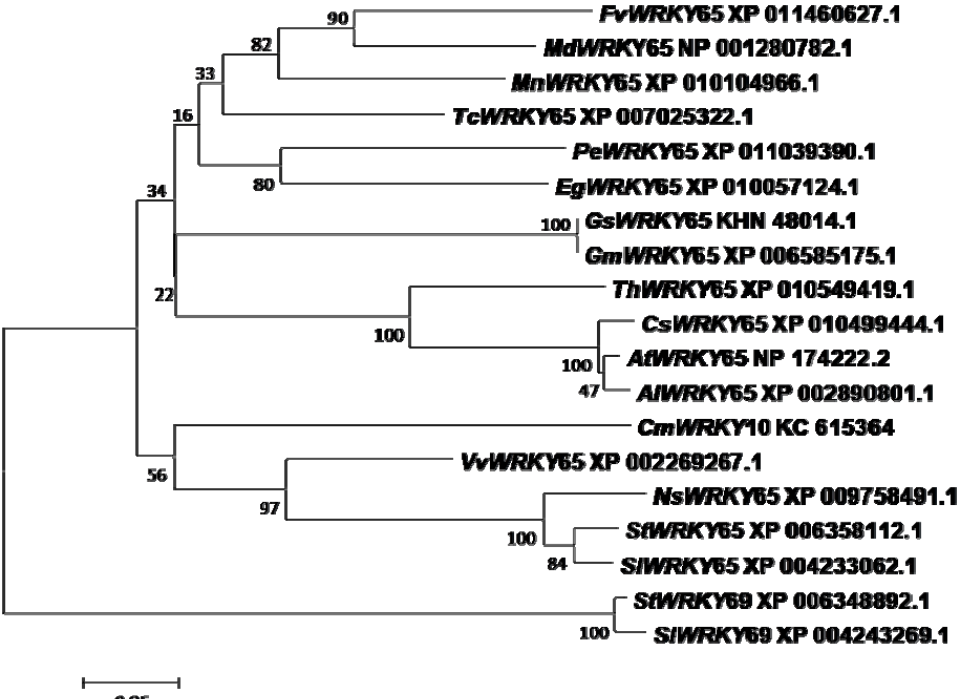
Figure 1. A phylogenetic tree showing the relationship between CmWRKY10 and another plant’s WRKY proteins. At first, amino acid sequences were aligned with ClustalX software after that aligned file was used to construct the phylogenetic tree using neighbor-joining method with 1000 bootstraps in MEGA5 software.